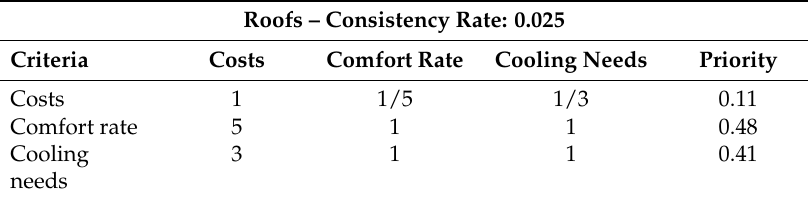
Table 6. Pairwise comparison matrix of criteria for roofs.